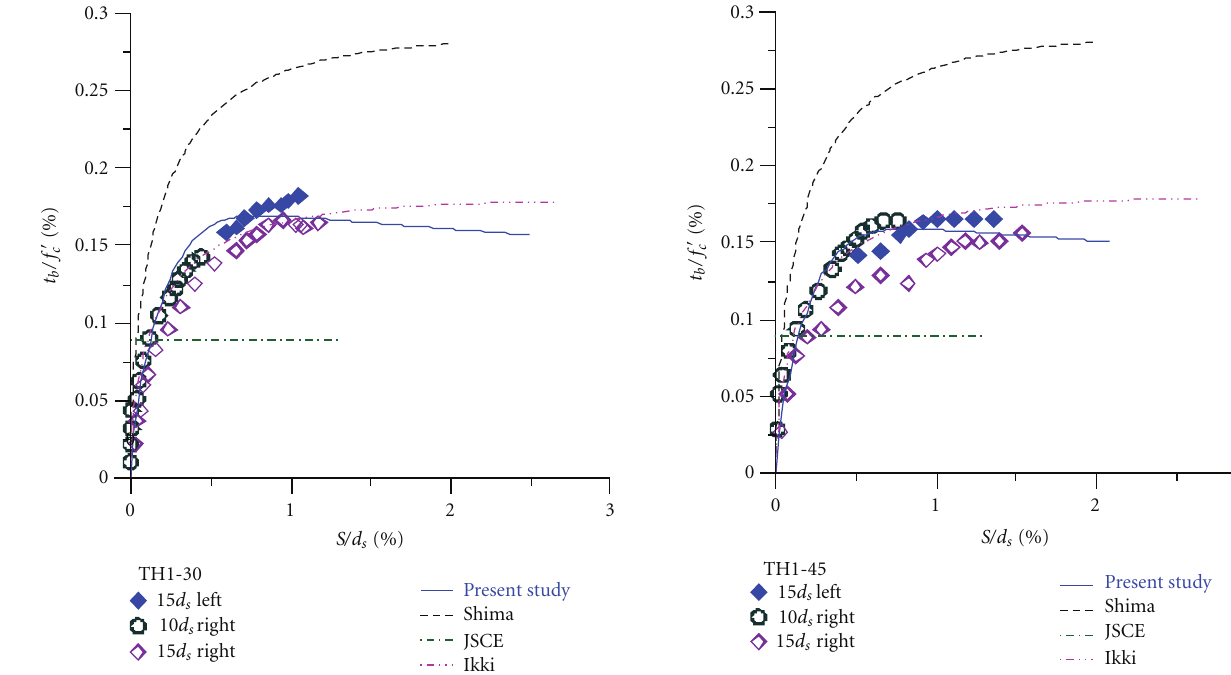
Figure 11: Bond stress-slip relationship of TH1-30 specimen.